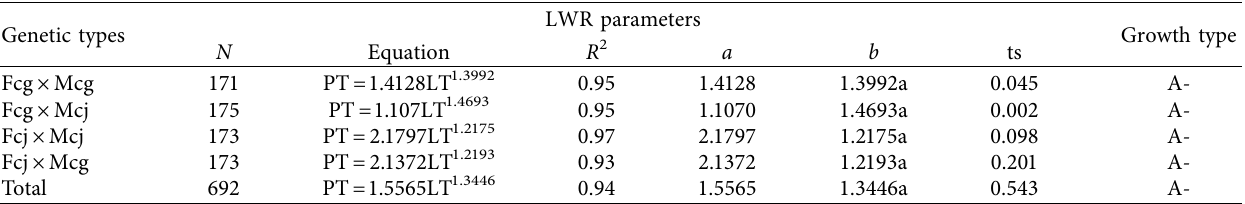
Table 2: Length-weight relationship and growth type of fry at 32 days of age (D32) in reciprocal hybridizations of C. gariepinus × C. jaensis. Genetic types